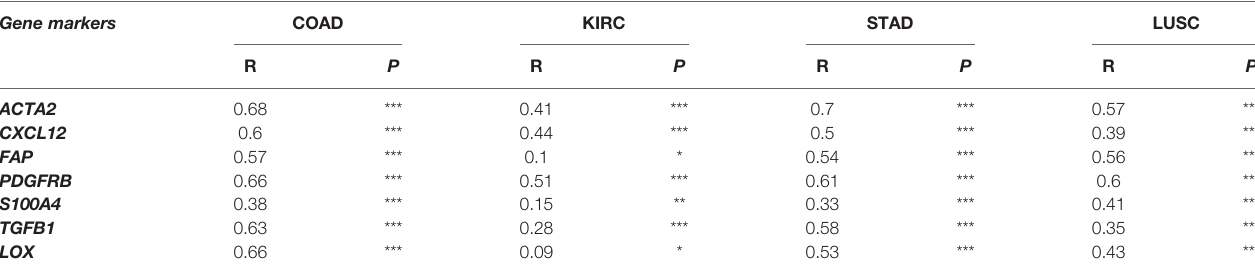
TABLE 2 | ILK correlation with CAF gene